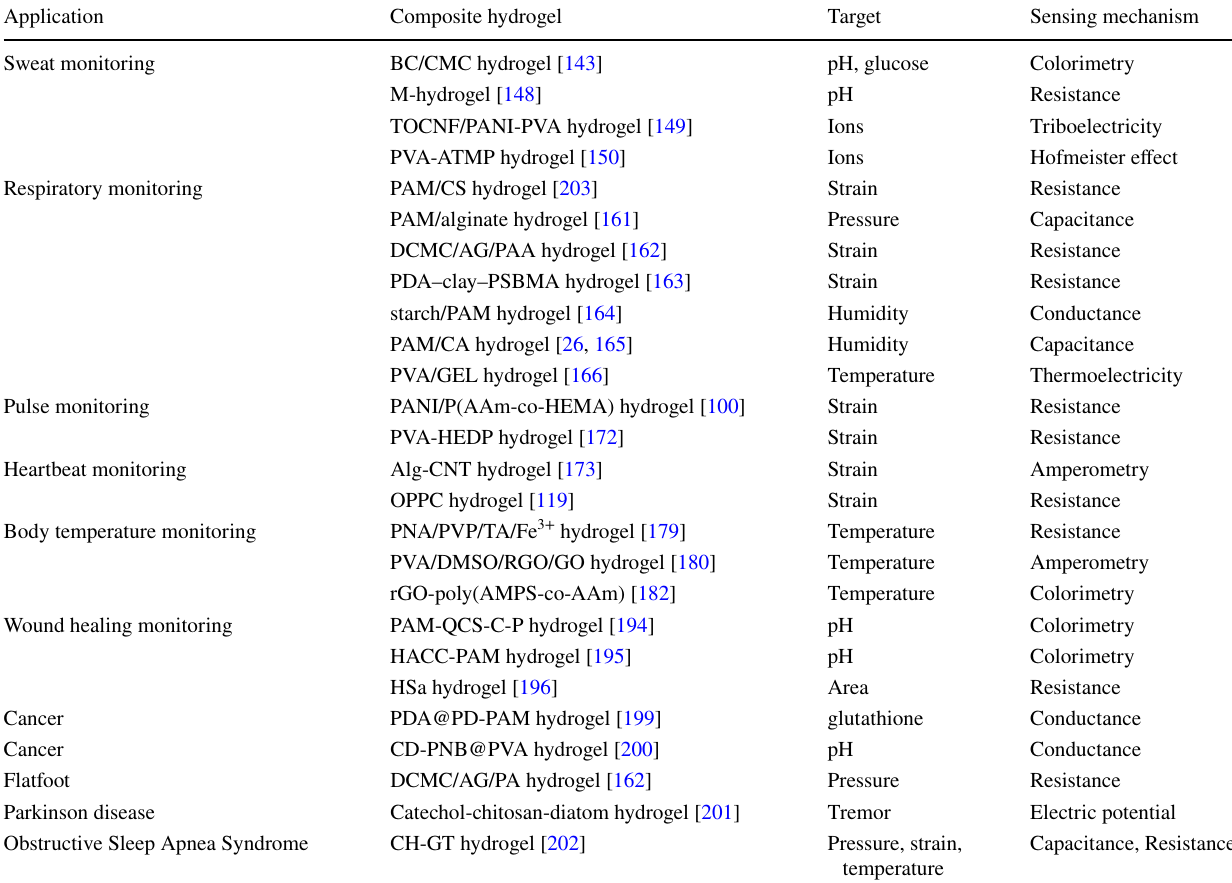
Table 3 Summary of sensing mechanisms for health monitoring